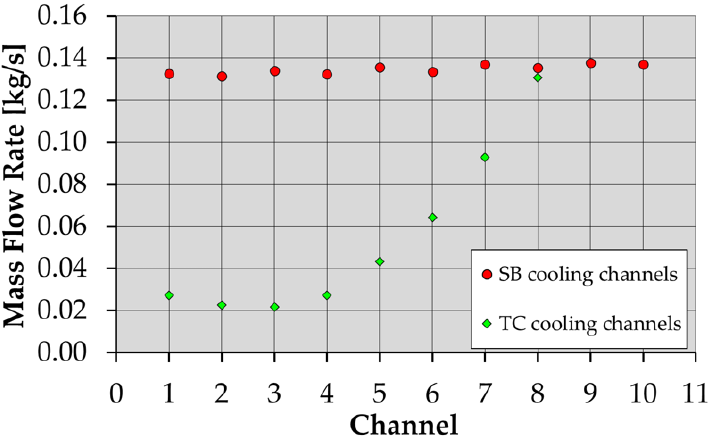
Figure 8. Coolant MFR distribution in the SB and TC cooling channels.